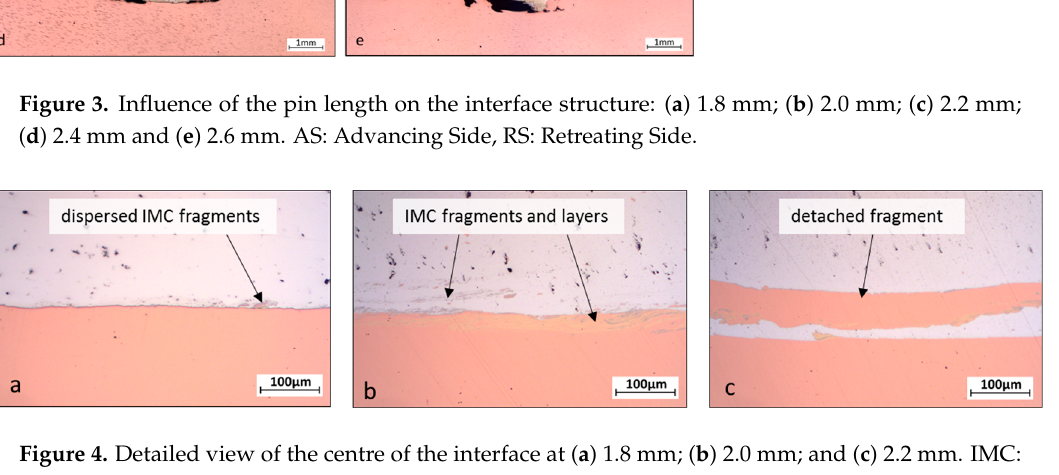
Figure 4. Detailed view of the centre of the interface at ( a ) 1.8 mm; ( b ) 2.0 mm; and ( c ) 2.2 mm. IMC: intermetallic compound.